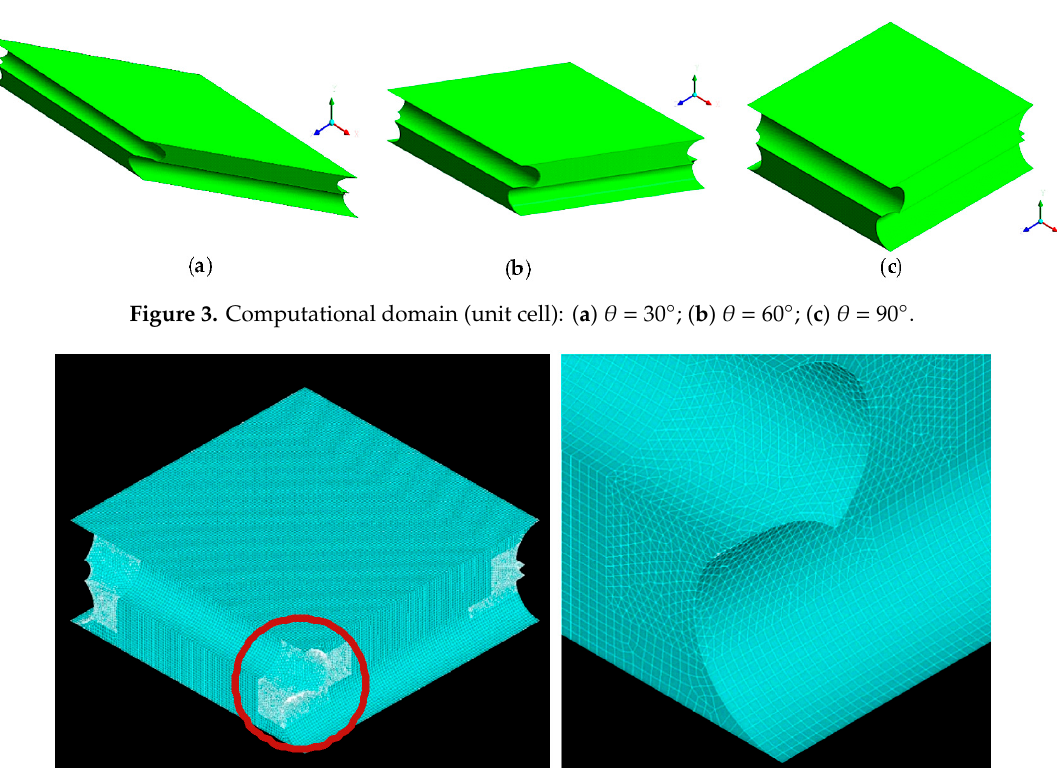
Figure 4. Mesh of a unit cell for case ( c ); one of the regions meshed with tetrahedra is highlighted.